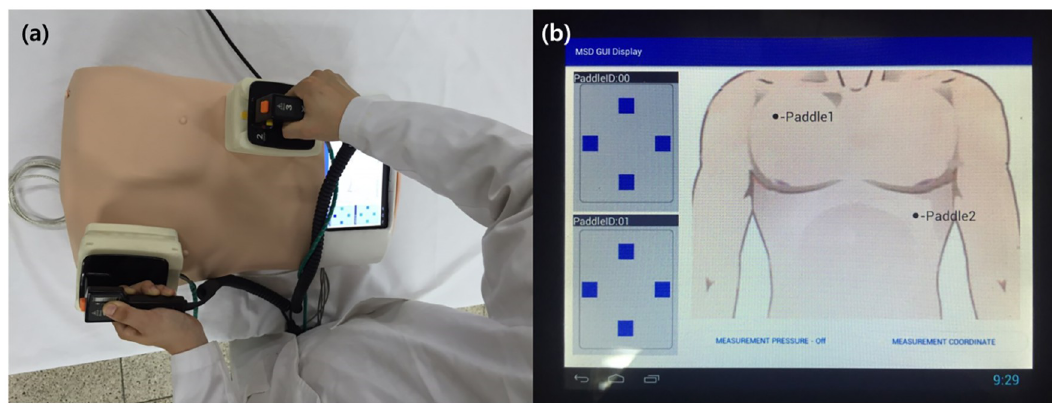
Fig 11. Fabricated whole defibrillation simulator with function of position measurement system. (a) demonstrate fabricated defibrillation simulator (b) display screen shows position measuring result.